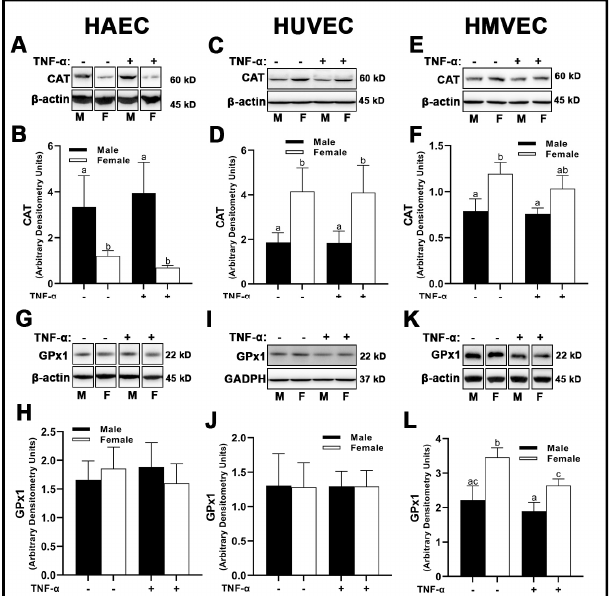
Figure 6. Expression of peroxidases in male and female endothelial cells. HAECs, HUVECs and HMVECs were cultured in starvation medium at ~80% confluency for 24 h with or without TNF- α (20 ng/mL). Protein expression of CAT ( A – F ) and GPx1 ( G – L ) were determined by Western blot. Quantification was performed using Image Lab (Bio-Rad Laboratories, Inc.). Protein was normalized to respective control bands ( β -actin or GAPDH). Data are expressed as mean ± SD from 4–6 experiments. Data were statistically analyzed with one-way ANOVA followed by Tukey post hoc multiple comparison analysis between groups. Values that do not share the same letter are significantly different from each other ( p ≤ 0.05).